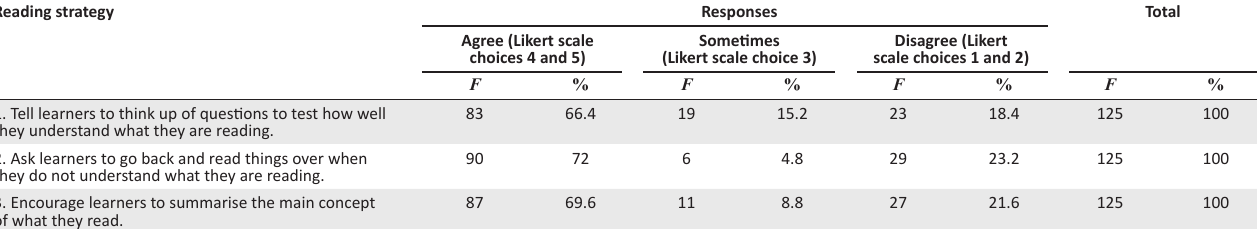
TABLE 3: Post-reading strategies. Reading